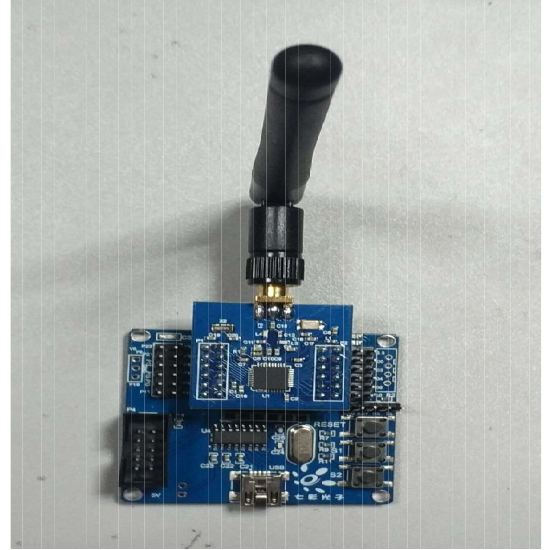
Figure 2. CC2530 radio frequency